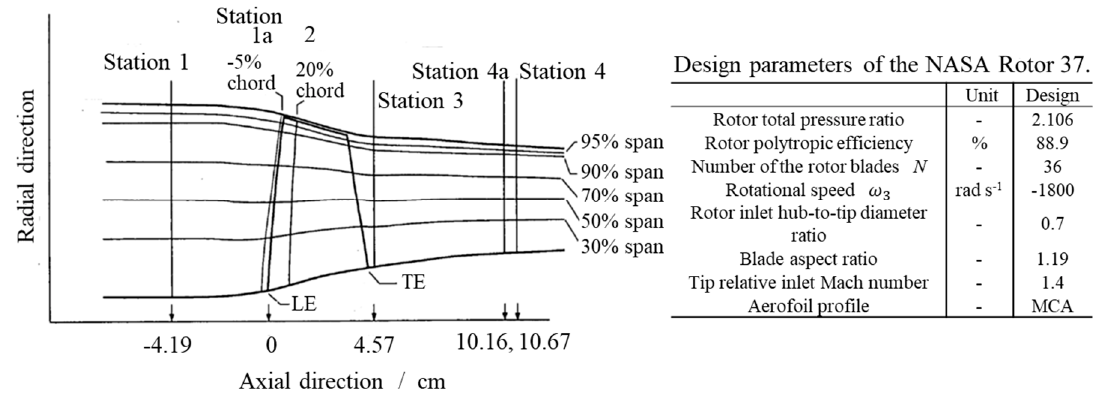
Figure 2. Meridional sketch of the NASA Rotor 37 used as the benchmark axial rotor test case [26].